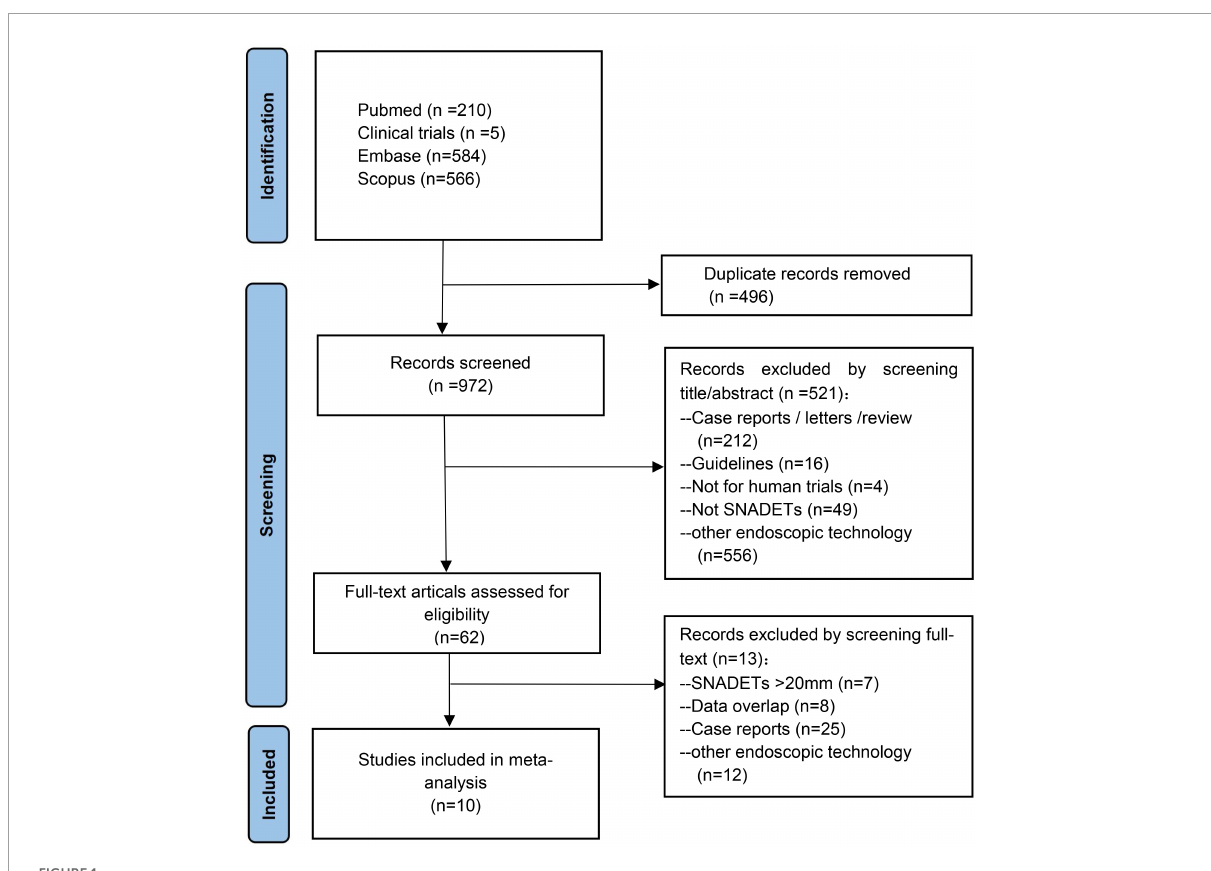
FIGURE1 The flowchart of the selection